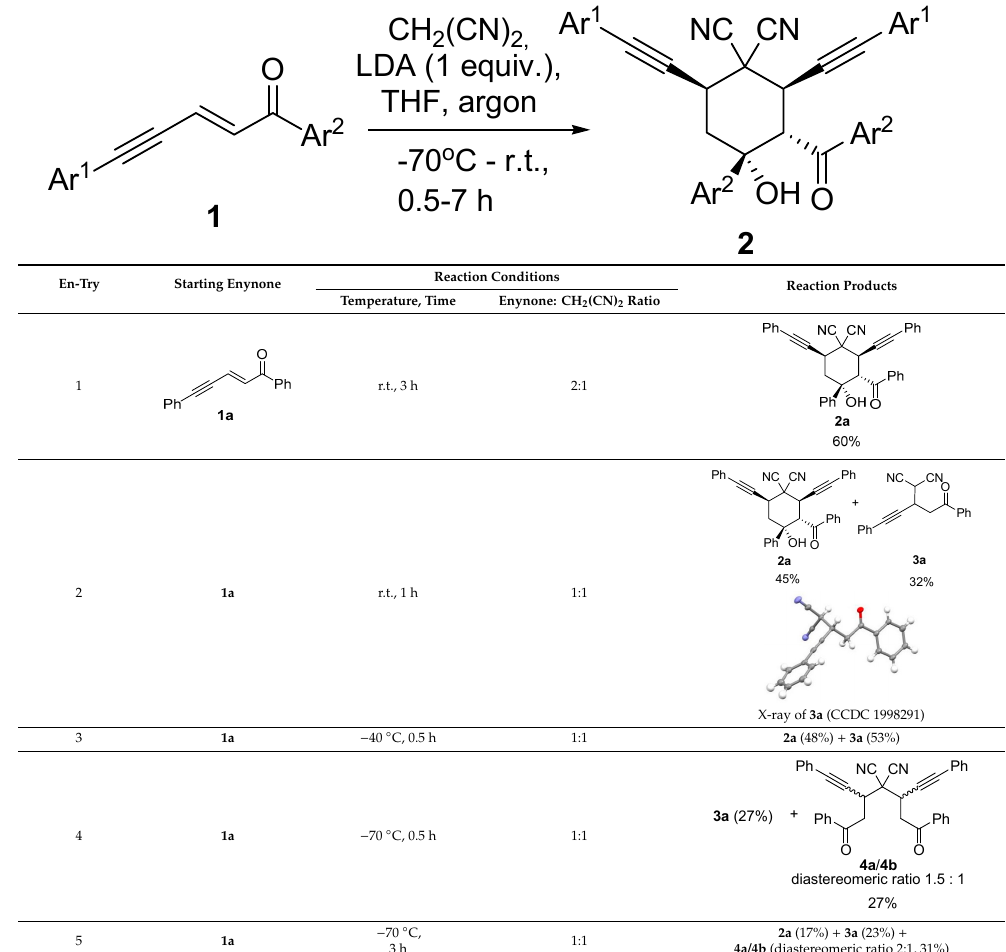
Table 1. Reactions of enynones 1 with malononitrile and lithium diisopropylamide (LDA) in THF leading to cyclohexanes 2 and other compounds (for X-ray structures, ellipsoid contours of probability levels are 50%).